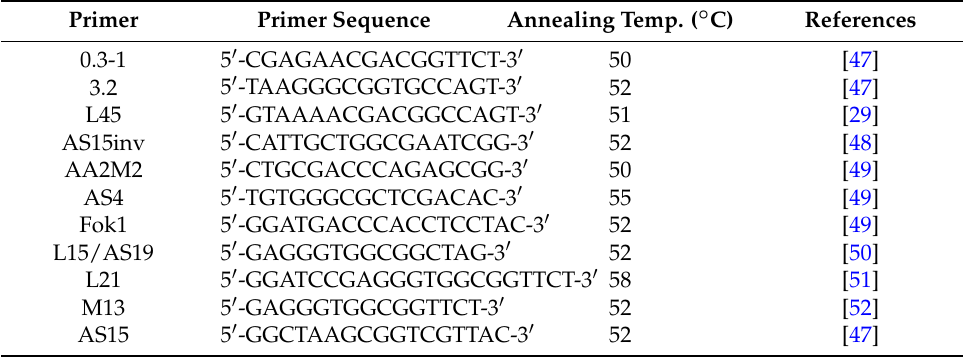
Table 1. Oligonucleotide sequence of the UP-PCR primers and their respective annealing temperatures [44]. Primer Primer Sequence Annealing Temp. ( ◦